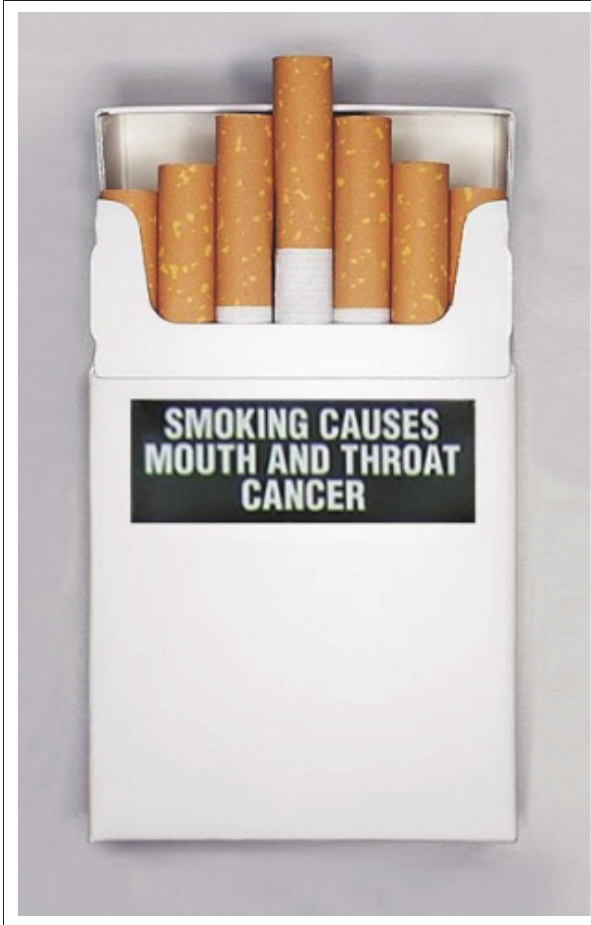
FIGURE 2: Both text and picture-based warning: A gangrene-affected foot. FIGURE 3: Text-based warning: Smoking causes mouth and throat